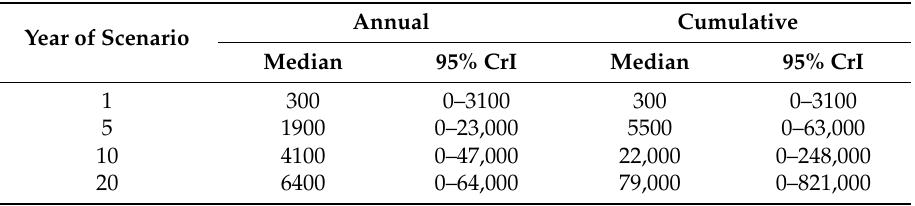
Table 3. Point and interval estimates for the annual and cumulative numbers of deaths attributable to PDR Gram-negative bacteraemia in the UK for selected years of the scenario.